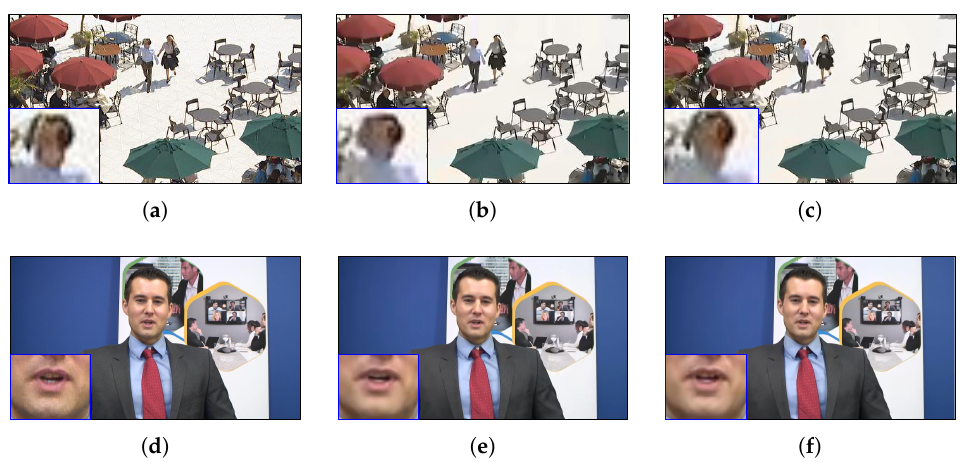
Figure 6. Visual comparison between VTM-11.0 NNVC-1.0 anchor and the proposed ABPN-based bi- prediction.Top: POC116 of BQSquare under LDB and QP37. Bottom: POC48 of Johnny under LDB and QP37. ( a ) Original frame of BQSquare . ( b ) VTM-11.0 NNVC-1.0 anchor (Y PSNR 28.465 dB). ( c ) ABPN- based bi-prediction (Y PSNR 28.505 dB). ( d ) Original frame of Johnny . ( e ) VTM-11.0 NNVC-1.0 anchor (Y PSNR 37.935 dB). ( f ) ABPN-based bi-prediction (Y PSNR 38.065 dB).